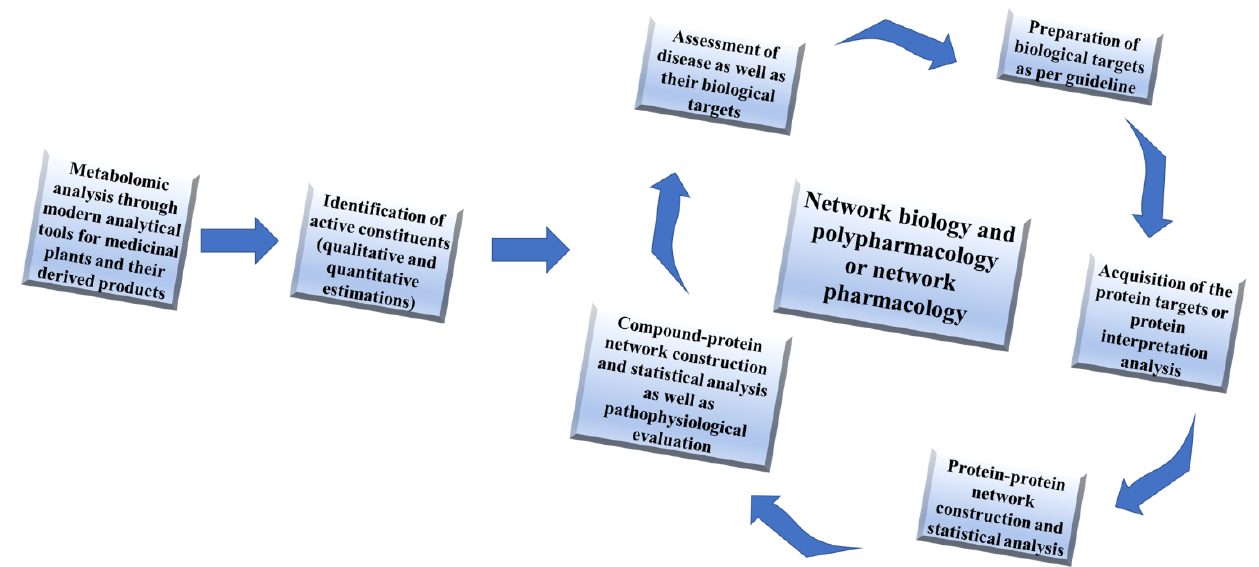
Figure 2. A systematic approach for network biology as well as polypharmacology.